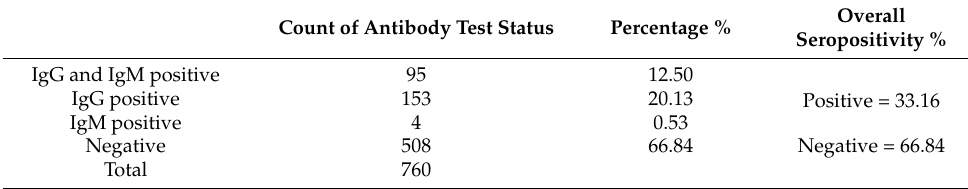
Table 1. Count and percentage of SARS-CoV-2 seroprevalence in cancer patients.